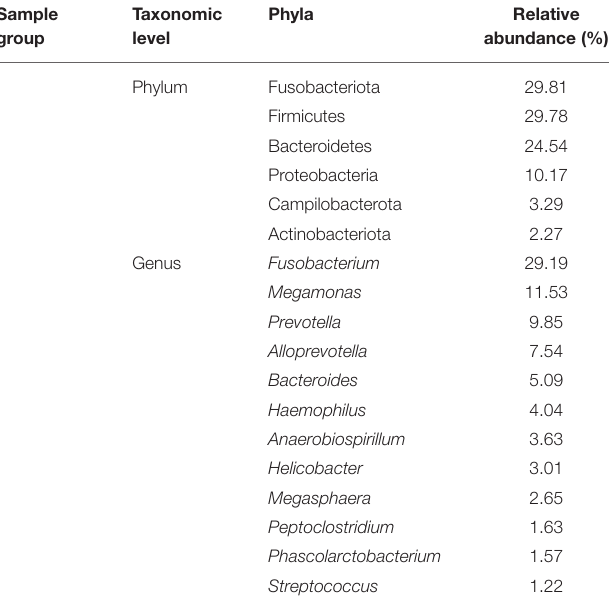
TABLE 4 | The predominant taxonomic profiles of the dog gut microbiota. Sample